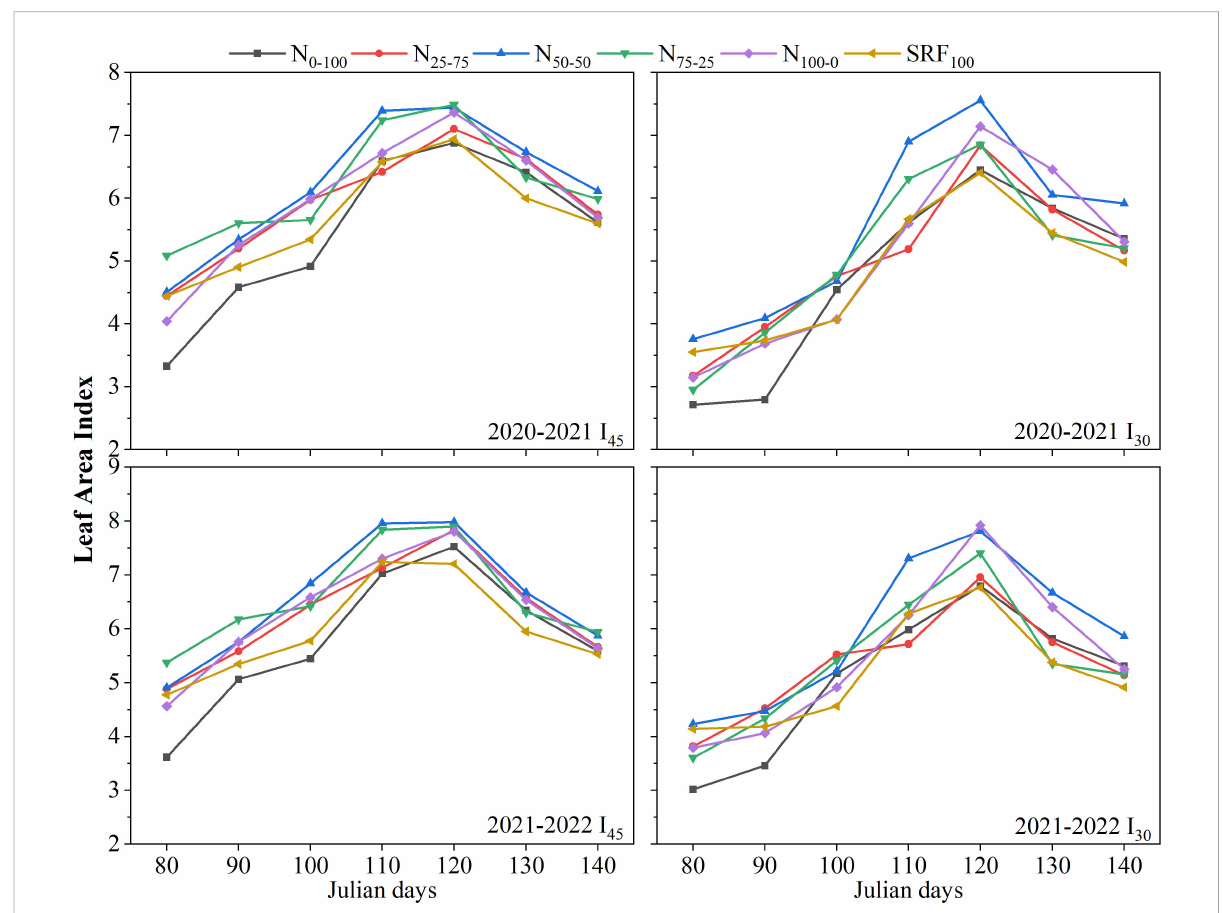
FIGURE 3 Variation of leaf area index under different irrigation scheduling and nitrogen application modes during 2020-2021 and 2021-2022 winter wheat-growing